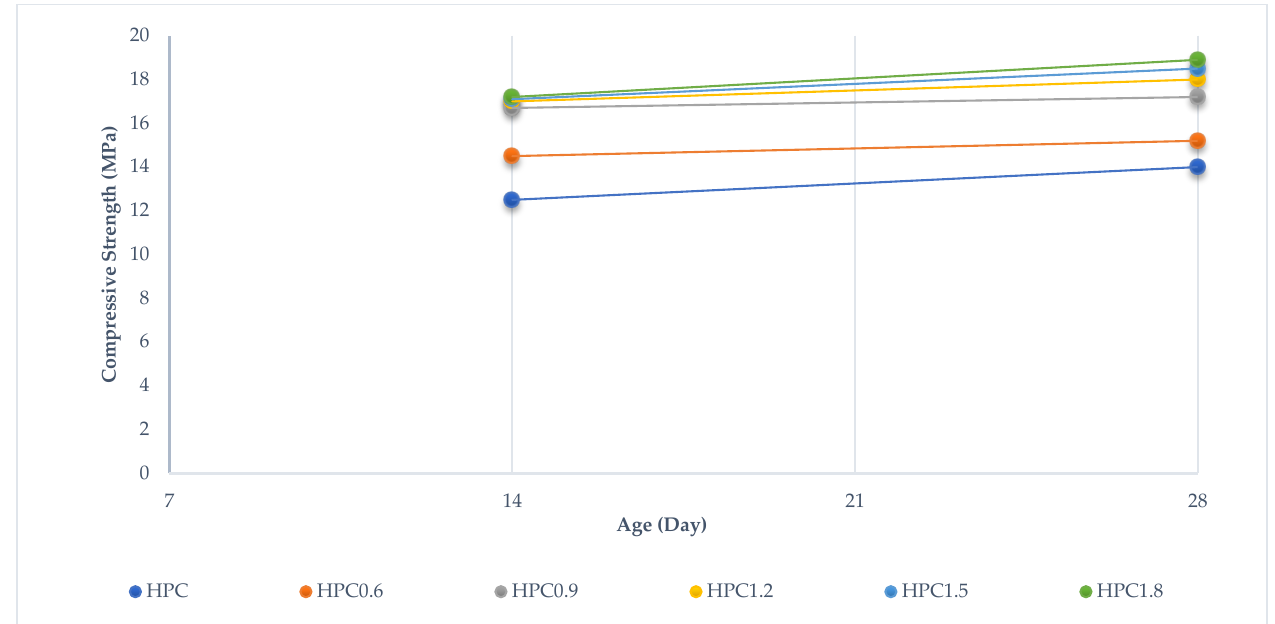
Figure 15. Flexural Strength Workability in Different Curing Periods.